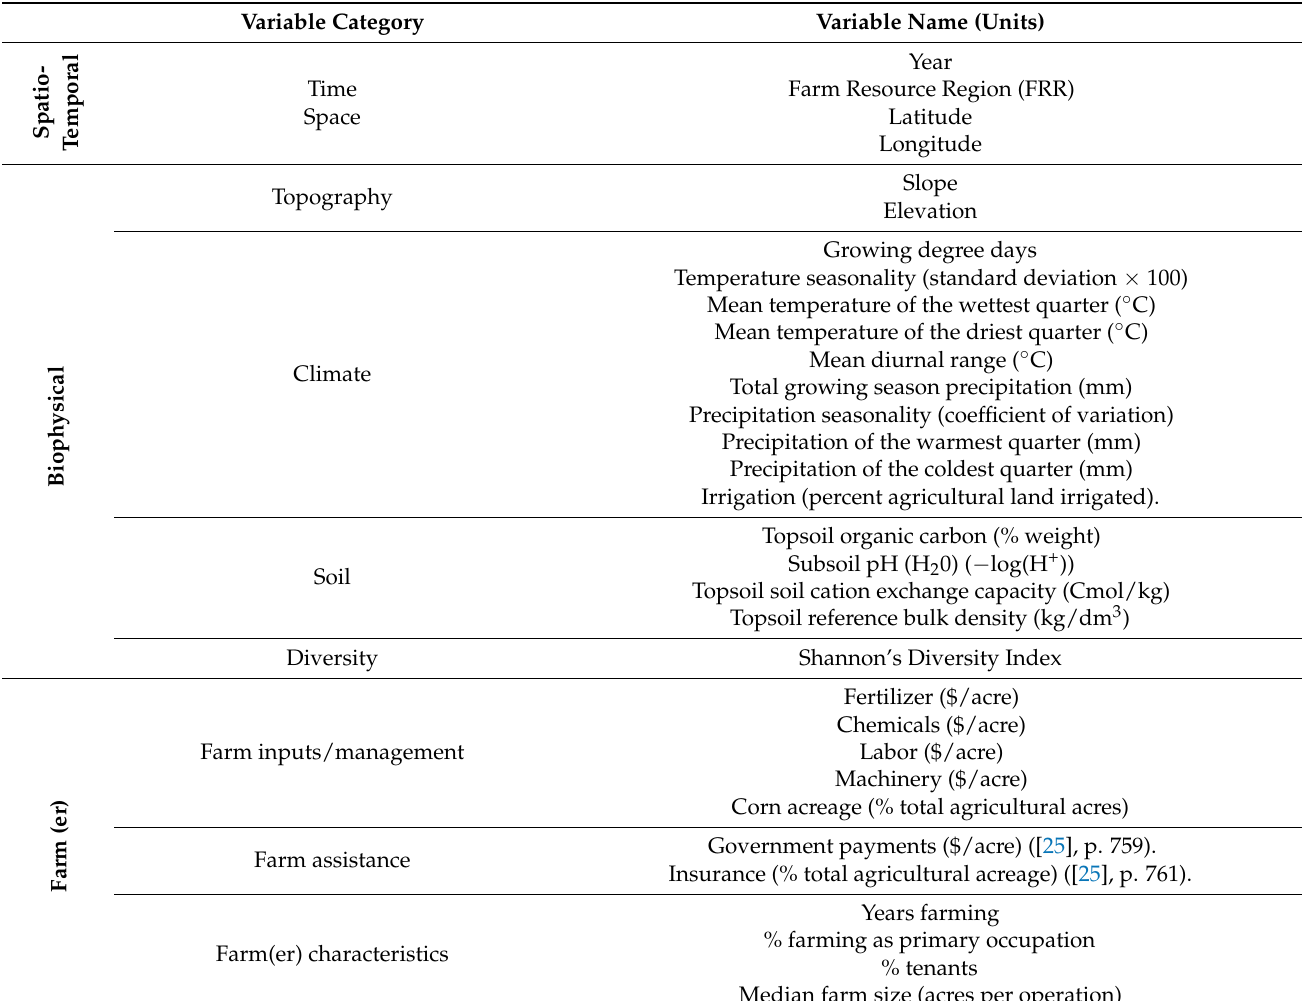
Table 1. County-level model covariates used in biophysical and farm(er) RF